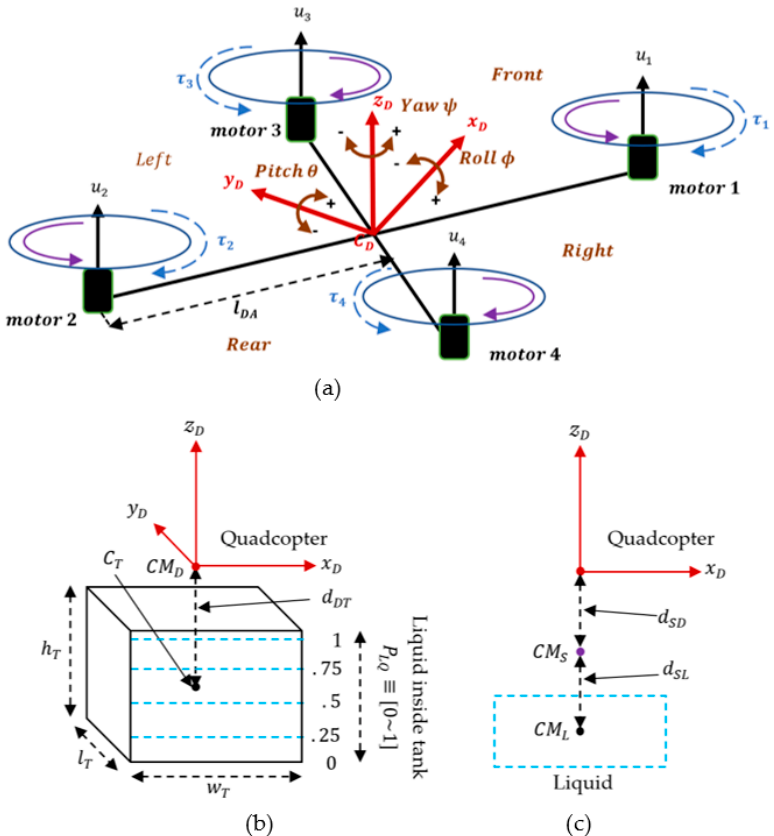
Figure 4. Quadrotor model schematic ( a ); liquid tank construction and liquid level assumption ( b ); different center of mass ( c ).